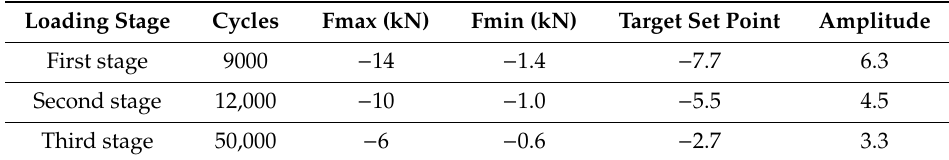
Figure 2. CTOD testing by the applicability of a fatigue pre-crack stage to the notched specimens on air environment. Table 1. Loading characteristics during fatigue precrack stage.